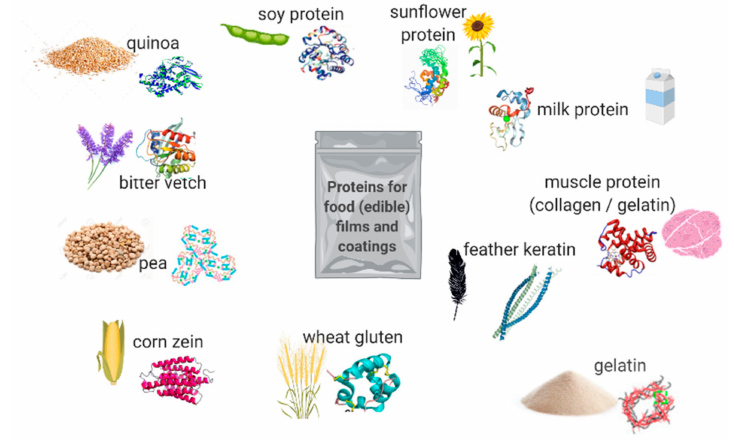
Figure 2. Most utilized materials for protein-based (edible) films and